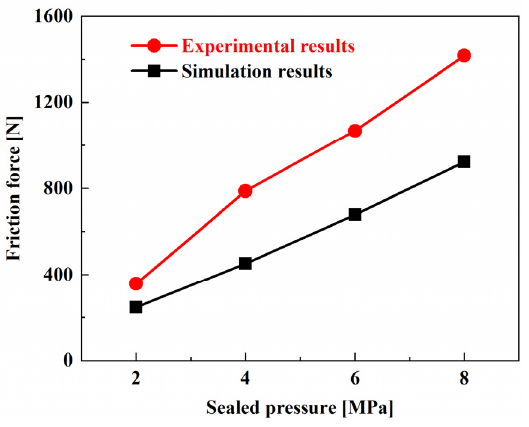
Figure 15. Friction force comparison between the experiment and simulation.